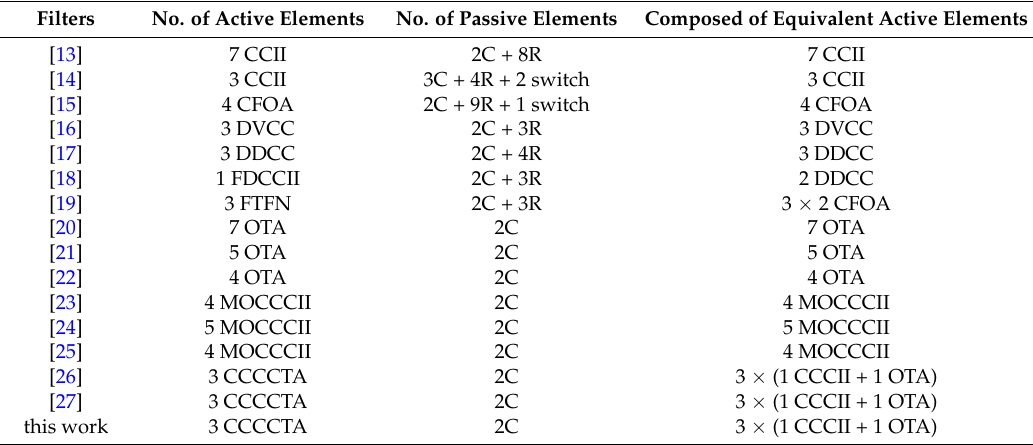
Table 1. Comparison of previously reported mixed-mode filters. 1